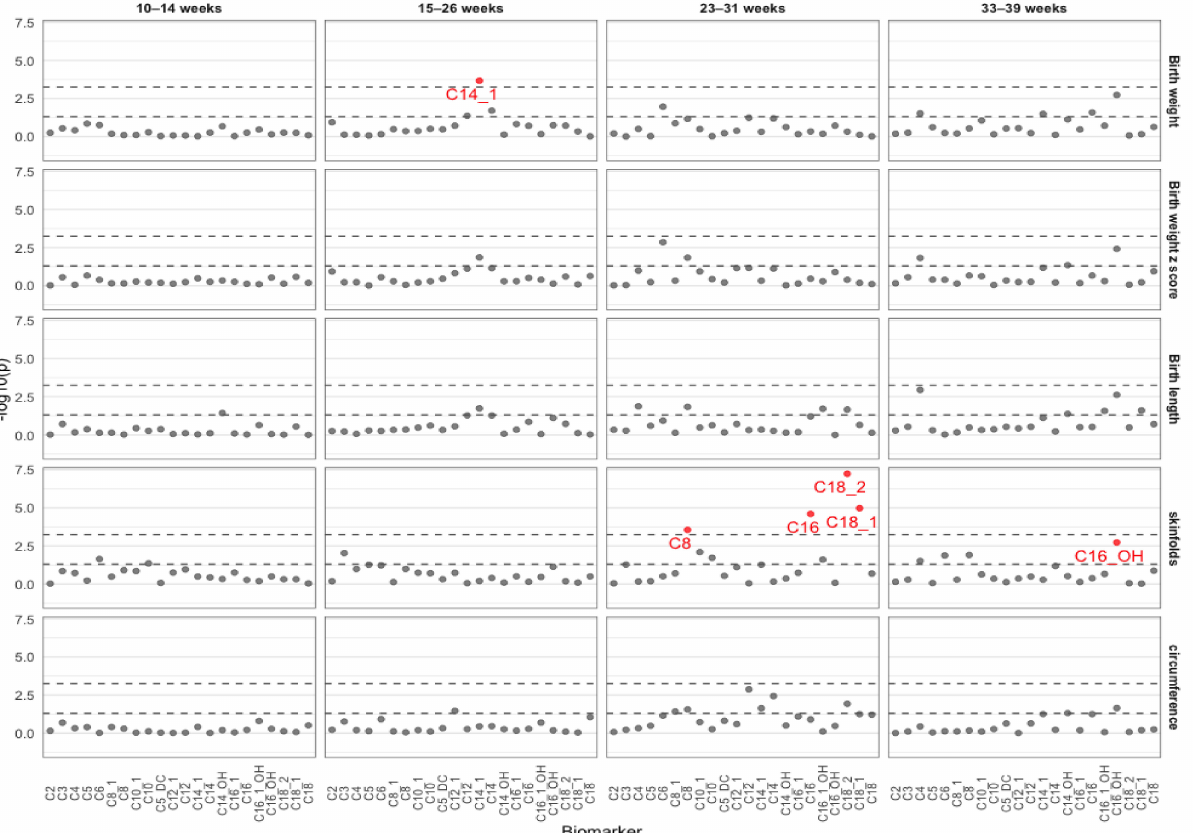
Figure 1. Manhattan plot for individual acylcarnitines in association with neonatal birthweight, birthweight z score, birth length, sum of skinfolds, and sum of circumferences. The lower dash line denotes the nominal p -value of 0.05, the upper dash line corresponds to the Bonferroni threshold of 0.05/88, and the p values that are FDR significant are colored